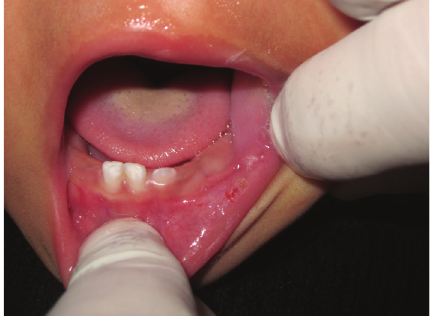
Figure 1: Mucocele in the lower lip of baby at 11 months.